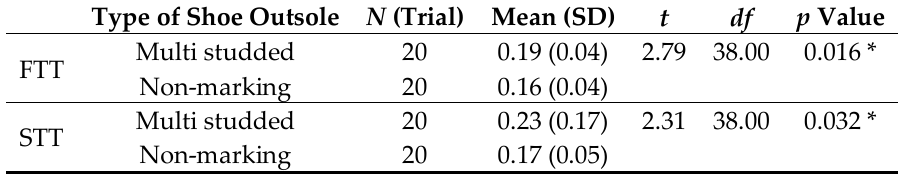
Table 1. Comparison of maximal horizontal force (Fy max ) between multi studded outsole design and non-marking outsole design during front translational traction (FTT) and side translational traction (STT) movement.